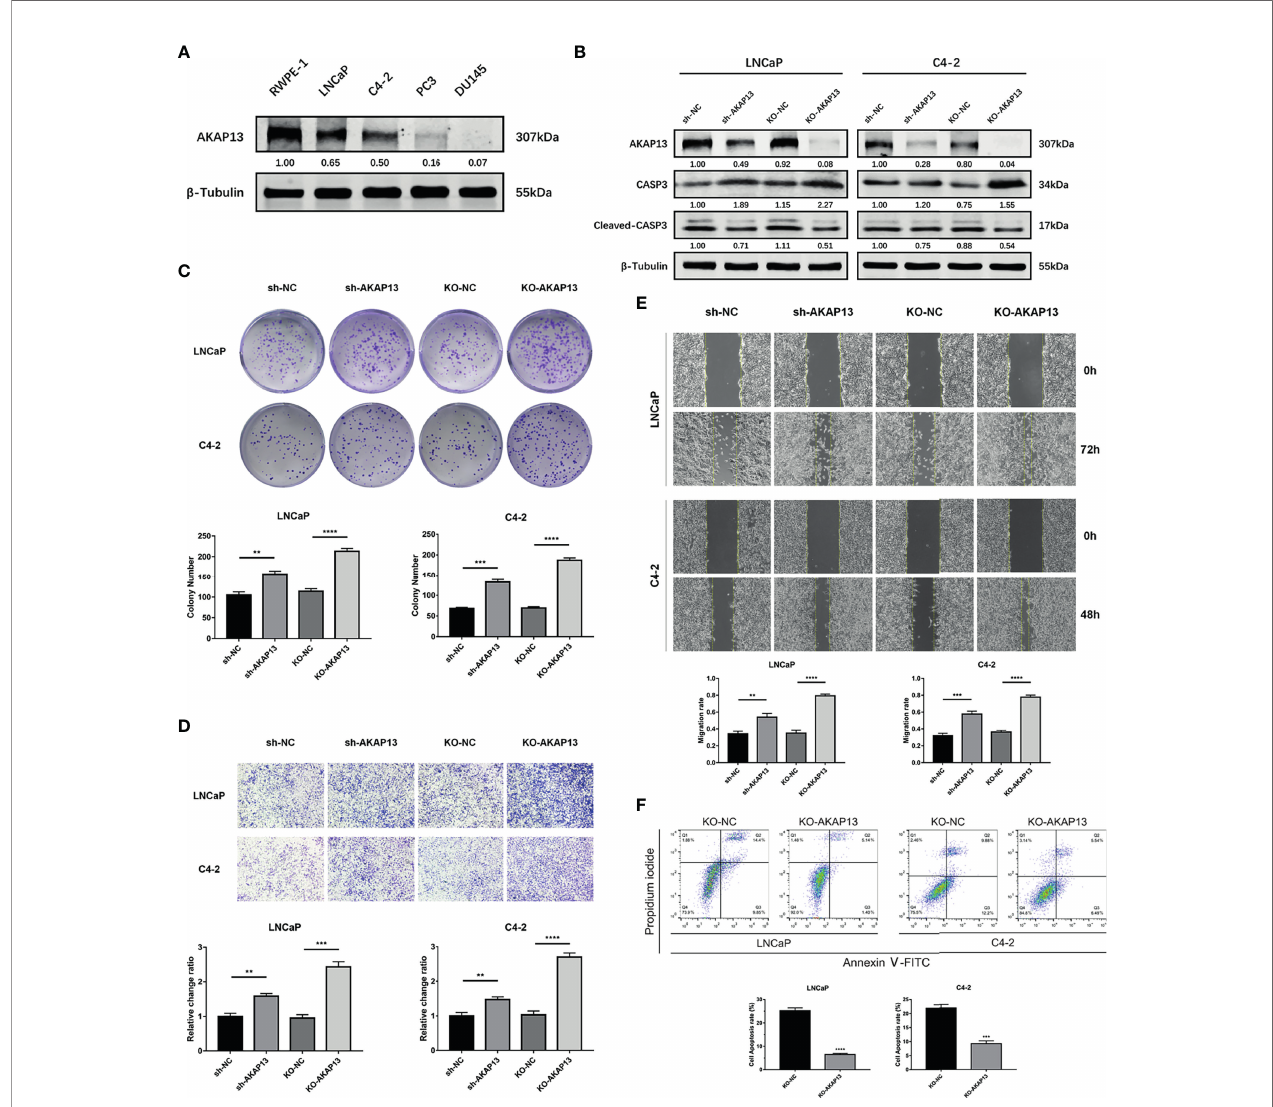
FIGURE 5 | AKAP13 expression changes can affect the malignant phenotype of PCa cells. (A) Western blotting analysis of AKAP13 protein expression in RWPE-1 and PCa cells. (B) Stable AKAP13 knockdown or knockout PCa cell lines were established, and the sequence with the highest inhibitory ef fi ciency was veri fi ed by Western blotting. After adding CCCP to stably transfected cell lines to induce apoptosis, the expression of apoptosis-related proteins changed. (C) Colony formation assayswere performedto assess the proliferation ability changes in AKAP13 inhibitorycelllines. (D) Transwellassaysand (E) Wound-healing assayswere performedto assess the invasion andmigration ability changes in AKAP13 inhibitory cell lines. (F) After adding CCCP to stably AKAP13 knockout celllines to induce apoptosis, then cell apoptosisratewasdeterminedbyAnnexinV-FITC/PIstaining. Thedatawere presentedasmeans± SDfromthreebiologicalreplicates. **P<0.01; ***P <0.001;****P<0.0001; Student ’ st-test. CCCP,